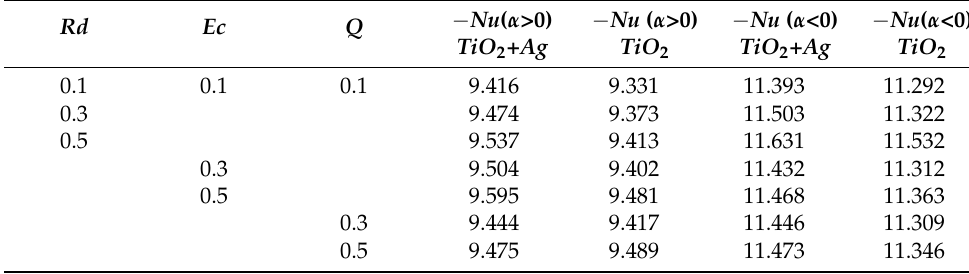
Table 6. Nusselt number Nu x versus different parameters.